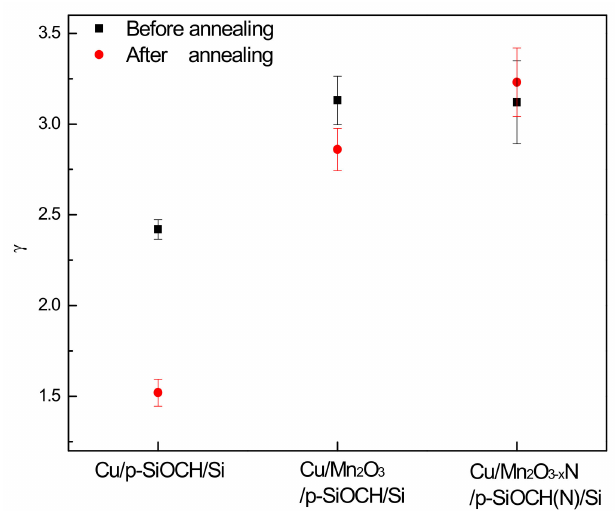
Figure 8. Electric-field acceleration factor of various Cu-gate MIS capacitors before and after